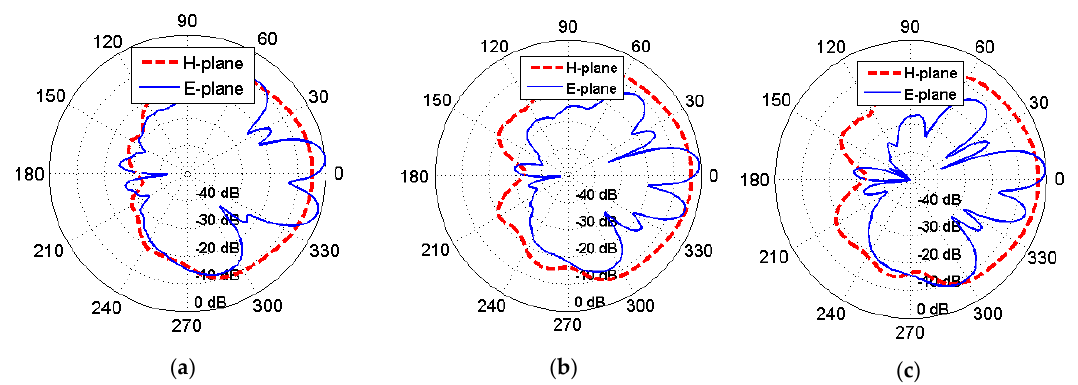
Figure 22. 3D far-field radiation patterns of Vivaldi antenna array with four-way SIW power divider at ( a ) 21 GHz, ( b ) 23 GHz, and ( c ) 24 GHz.